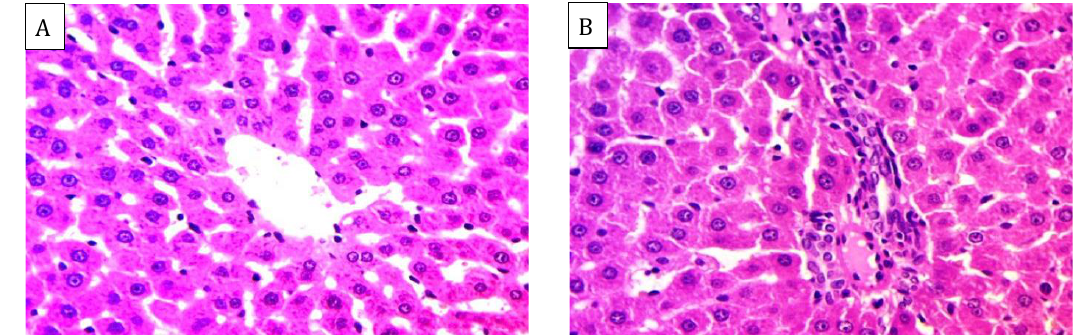
Figure 6 . Liver sections of rats fed on 1% cholesterol diet and treated intraperitoneally with 0.8 mg/kg BW/day atorvastatin (treatment control, Group 6). A: Normal hepatolobular structure. B: Slight congestion of the portal veins associated with slight, focal infiltration with mononuclear inflammatory cells. H&E, 400× D